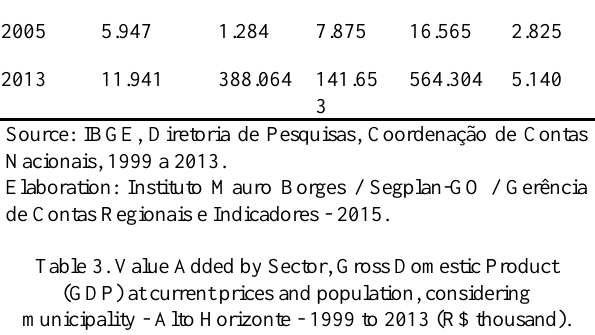
Table 3. Value Added by Sector, Gross Domestic Product (GDP) at current prices and population,